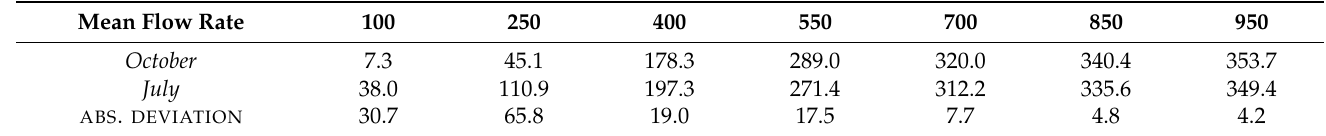
Table 1. Numerical values coming from the seasonal changing curves in terms of mean flow rate depicted in Figure 7.